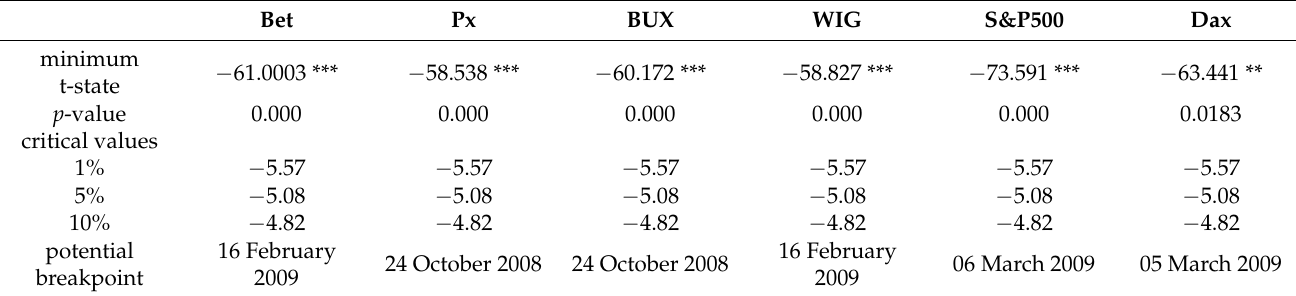
Table A4. Empirical Results of the Zivot–Andrews